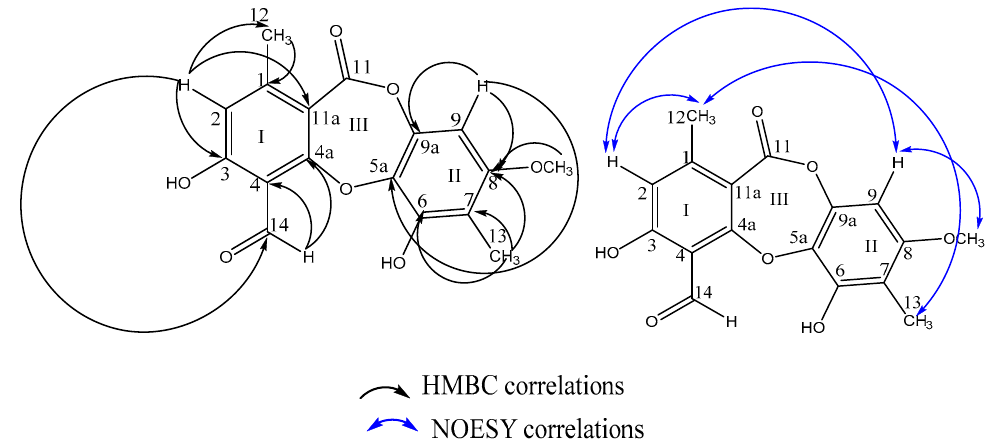
Figure 2. Selected 2D-NMR correlations of Cordidepsine.